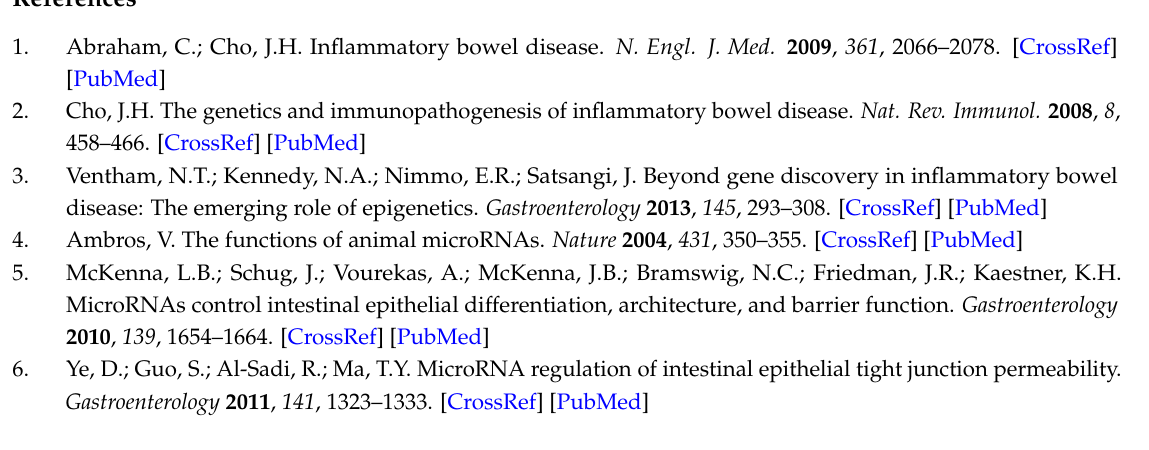
Table S1: Comparison between inflamed mucosa of active CD and EEN-M. Differentially expressed miRNAs satisfying the higher stringency criteria. Table S2: Comparison between non-inflamed mucosa of active CD and EEN-M. Differentially expressed miRNAs satisfying the higher stringency criteria. Table S3: Comparison between EEN-M and healthy control. Differentially expressed miRNAs satisfying the higher stringency criteria in EEN-M (miRNAs in red color were also dysregulated in non-inflamed mucosa of active CD vs. healthy control). Acknowledgments: This study was funded by National Natural Science Foundation of China (81500429 and 81570500). Microarray experiments were performed by Kang Chen Bio-tech, Shanghai, China. Author Contributions: W.M.Z. and J.S.L. conceived and designed the experiments; Z.G. performed the experiments; Z.G., Y.L. and J.F.G. analyzed the data; L.L.G., Z.M.W. and L.C. contributed materials; and Z.G. wrote the